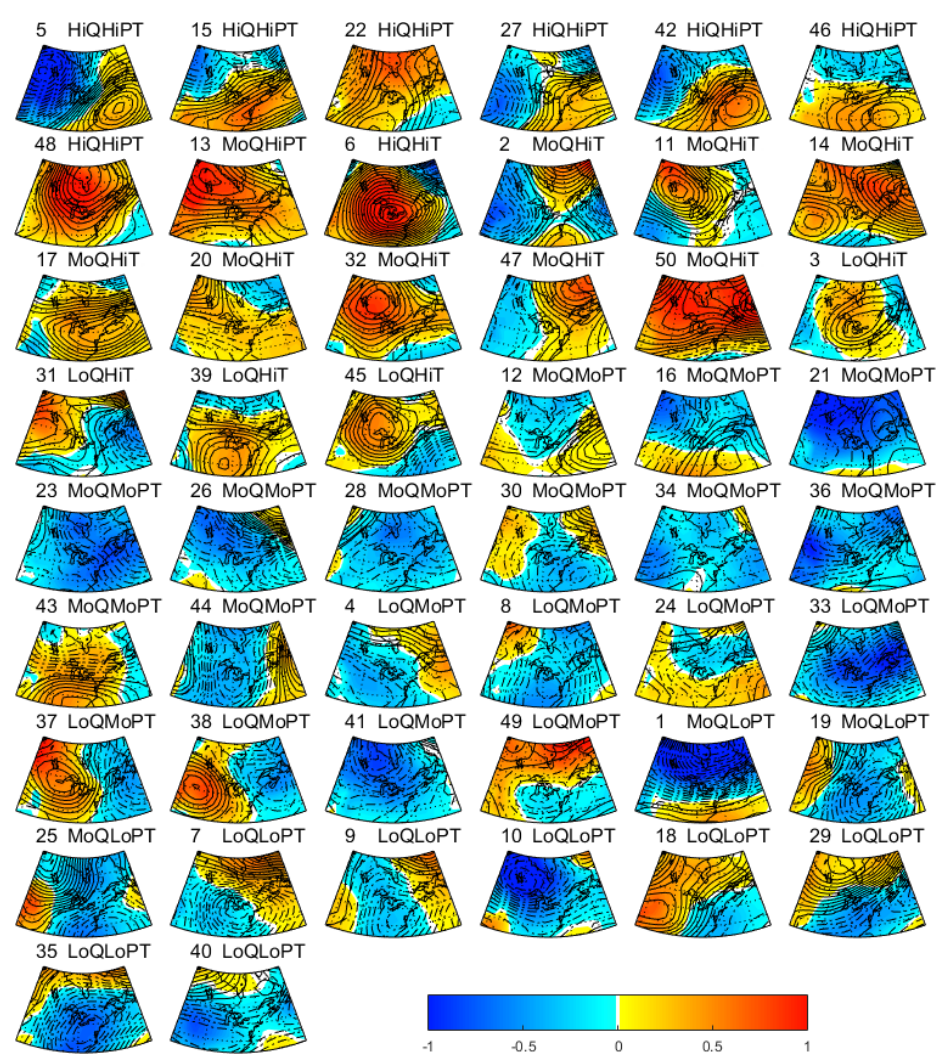
Figure 11. Internal change of T 850 (shade) and Z 500 (black lines, interval 2m) between the historical and the 2040s periods in January– February for each